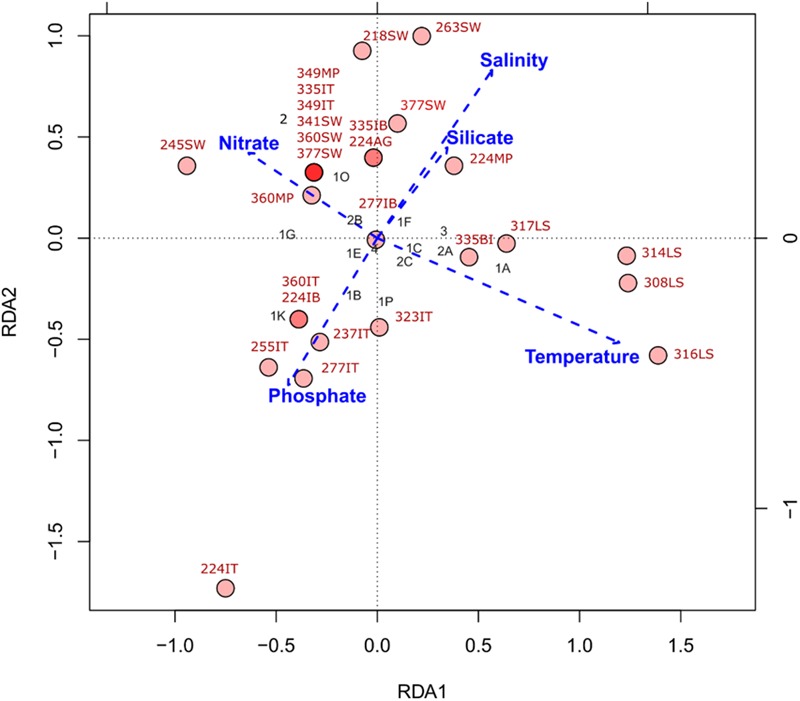
Redundancy analysis (RDA) of nifH subcluster presence absence in Central Arctic samples and environmental variables. Environmental variables: temperature, salinity, nitrate, phosphate and silicate were standardized by z-scoring prior to RDA. The red circles represent the different samples and the intensity of the color indicates if there is one (light red) or many (dark red) samples at that coordinate in the plot. Sample names in red correspond to those in Supplementary Table S1. The black labels correspond to the different subclusters of nifH (Cluster number 1, 2, 3, or 4; and the subcluster letter A-K). The explanatory variables constrained ∼57% of the variance in the nifH subclusters across samples. The significance of this type I scaling was 0.001 and the residuals were mostly distributed around zero (Supplementary Figure S3).